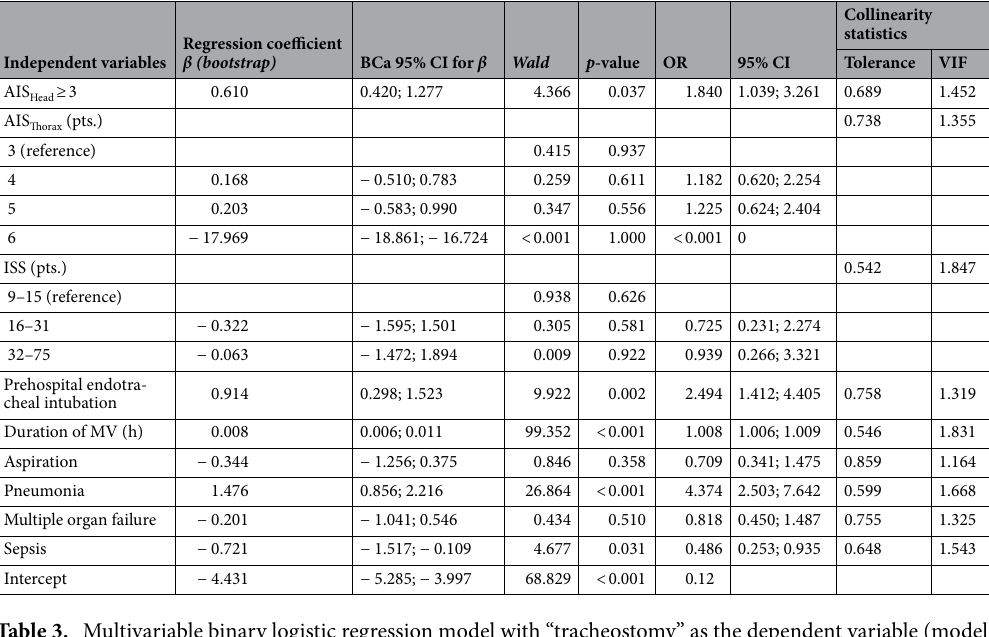
Table 3. Multivariable binary logistic regression model with “tracheostomy” as the dependent variable (model A). Nagelkerke’s R 2 was 0.602, ROC AUC was 0.941, 95% CI [0.925, 0.958] ( p < 0.001), the Hosmer–Lemeshow- Test was statistically significant ( χ 2 = 23.267, df = 8, p = 0.003), the omnibus test was statistically significant χ 2 = 444.700, df = 12, p < 0.001.